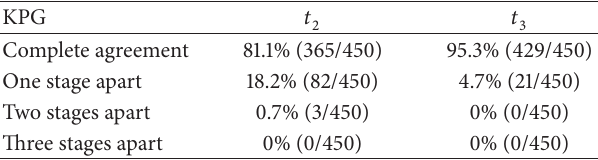
Table 3: Interrater agreement and disagreement at 𝑡 2 and 𝑡 3